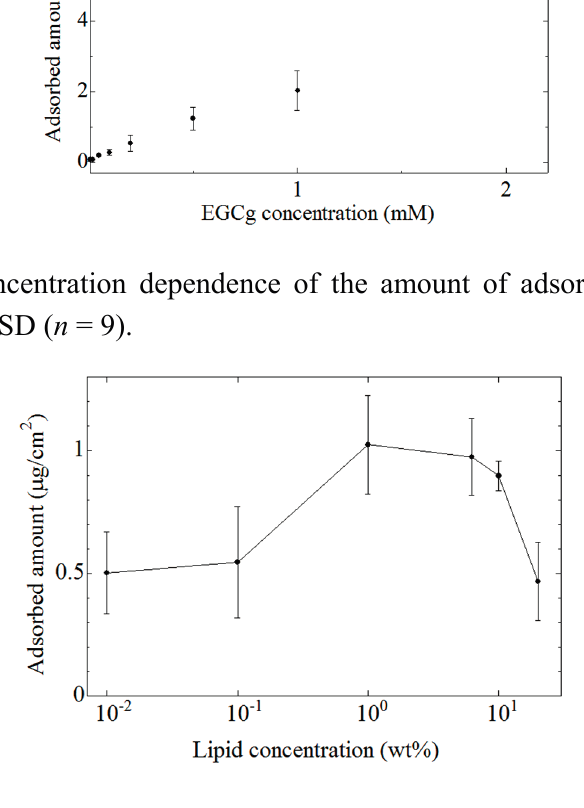
Figure 7. Lipid concentration dependence of the amount of adsorbed EGCg. Data are expressed as mean ± SD ( n = 9). The lipid concentration is shown by wt % in comparison with the PVC